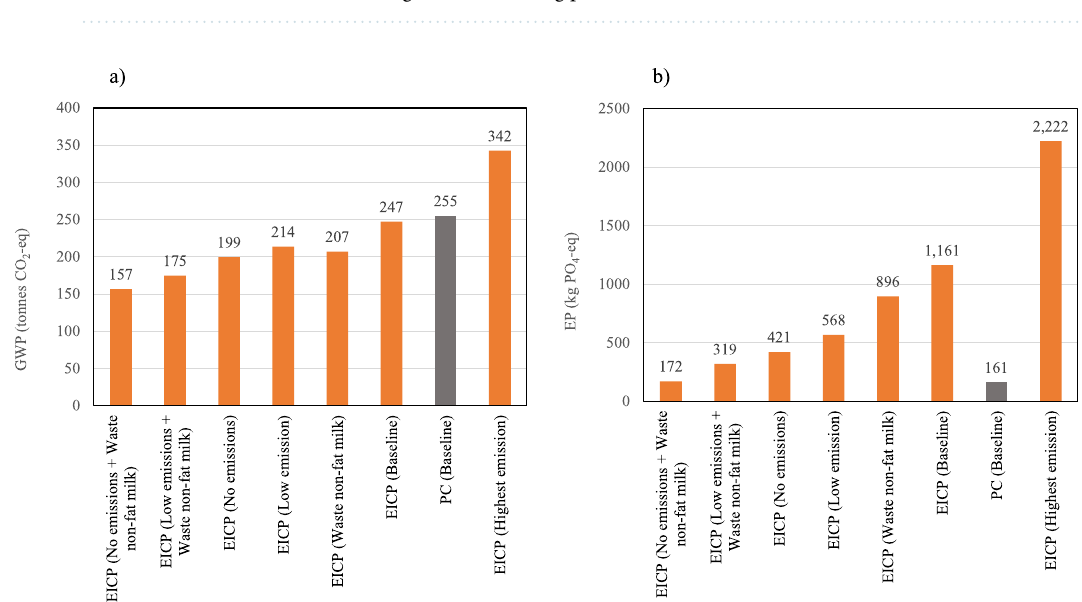
Figure 6. Abiotic depletion potential of resources for the PC and EICP soil stabilization techniques: ( a ) total and individual emissions, and ( b ) highest contributing processes.